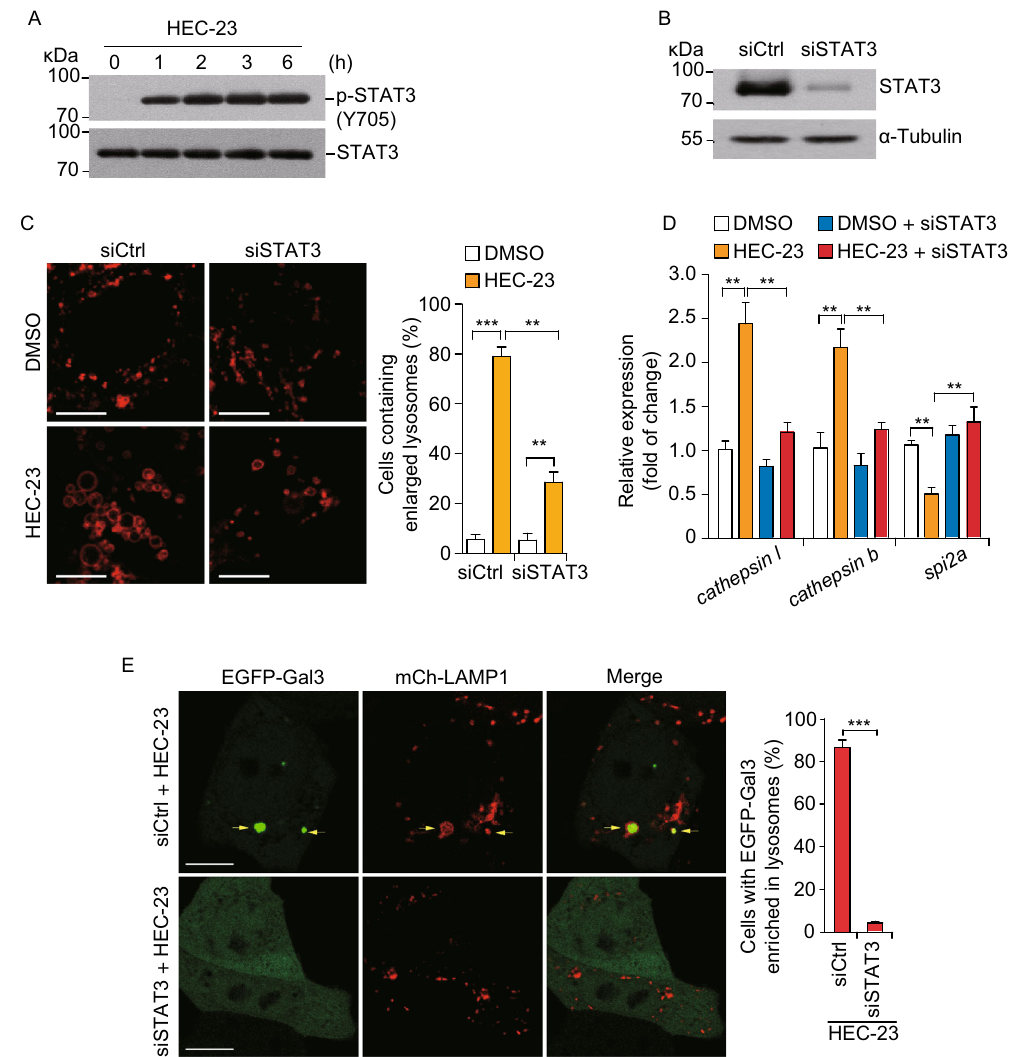
Figure 5. HEC-23-induced enlargement of lysosomes depends on STAT3 activation. (A) Immuno-blotting of STAT3 phosphorylation at Y705 in HeLa cells following HEC-23 treatment. (B) Immuno-blotting of STAT3 in HeLa cells treated with siSTAT3. (C) Representative images (left) and quanti fi cation (right) of lysosomes labeled with mCherry-LAMP1 in HEC-23-treated HeLa cells pretreated with control siRNA (siCtrl) and STAT3 siRNA (siSTAT3). (D) qPCR-analysis of the expression of STAT3 target genes in siCtrl or siSTAT3 cells treated with HEC-23. (E) Representative images (left) and quanti fi cation (right) of lysosome damage in HEC-23-treated HeLa cells pretreated with control siRNA (siCtrl) and STAT3 siRNA (siSTAT3). The concentration of HEC-23 was 10 μ mol/L in all treatments. Data representing mean ± SEM were derived from 3 independent experiments. ** P < 0.01, *** P < 0.001 (Scale bars, 10 μ